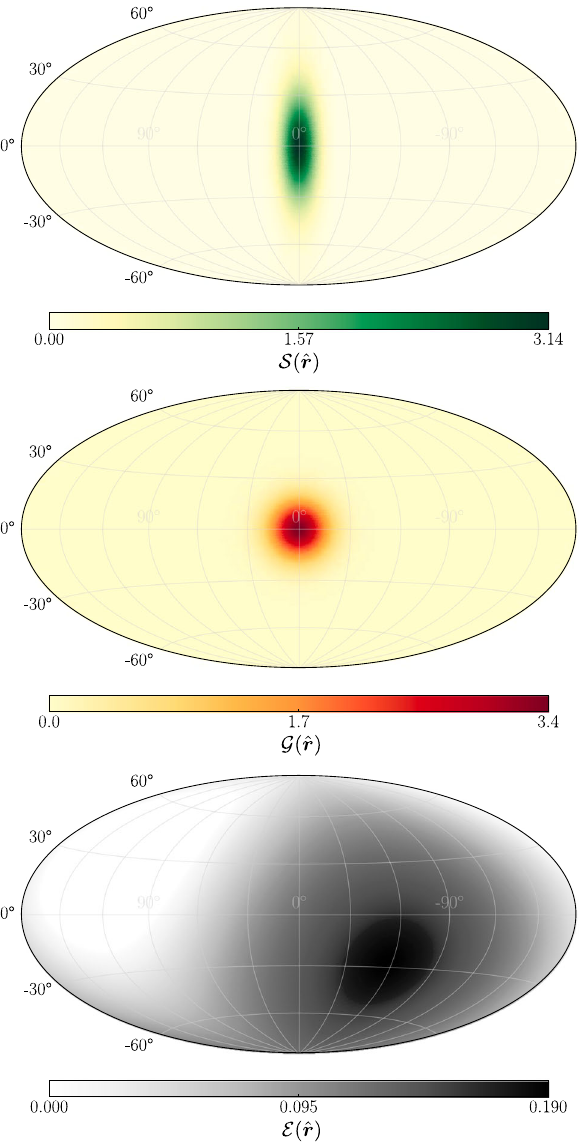
Fig. 3 Normalized probability density distributions for (top) signal part S i ( ˆ r ) , (middle) the Gaussian reference part G i ( ˆ r ) , and (bottom) the geometrical exposure E ( ˆ r ) . For the signal and Gaussian reference parts, the cosmic-ray direction ˆ Θ i is centered at Galactic coordinates ϑ = 0 ◦ and ϕ = 0 ◦ and the ellipse geometry is δ δ = 10 ◦ where the major axis is aligned with the ˆ e ϑ unit min